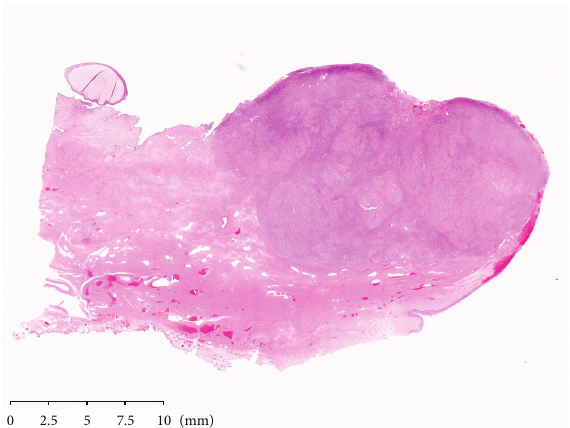
Figure 1: Neoplastic proliferation was located in the stroma of the uterinecervix(H&Eoriginalmagnification × 0.4,NanoZoomerDig- ital Pathology